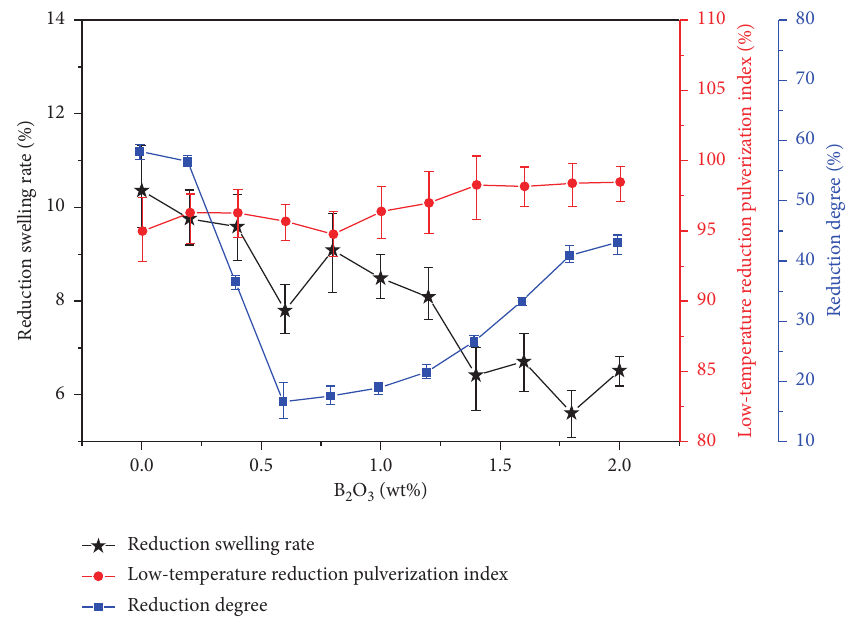
Figure 7: Metallurgical properties of pellets with different B